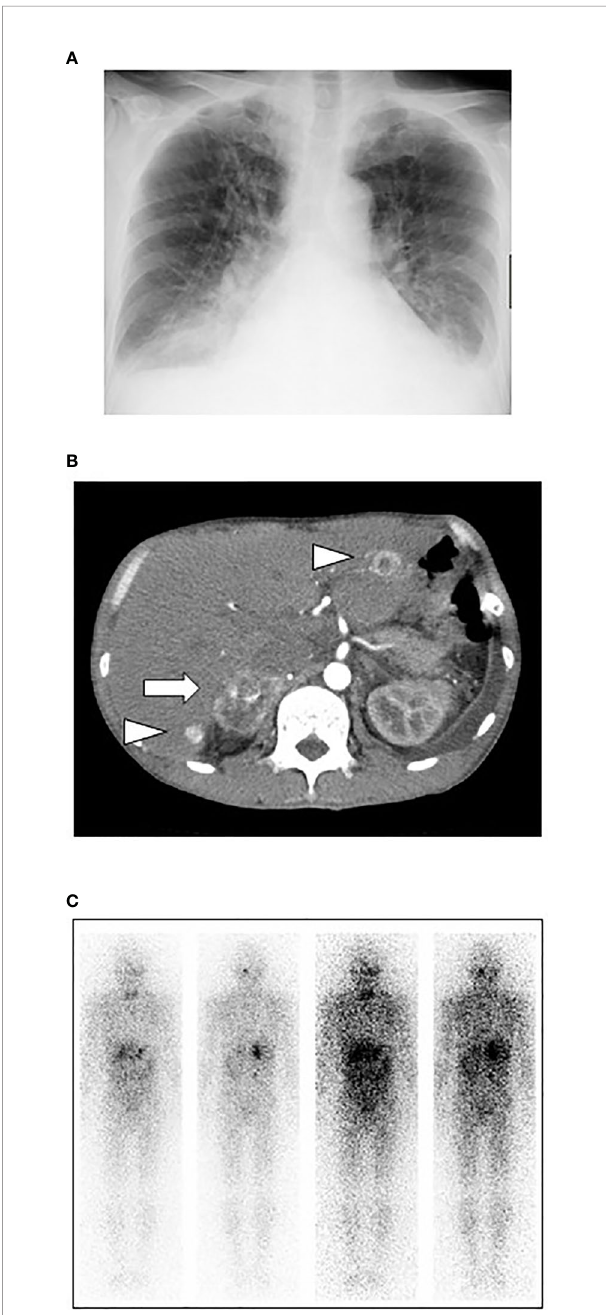
FIGURE 1 | (A) In chest X-ray, permeability was reduced in bilateral lower lung fi eld and butter fl y shadow was observed. Cardio-thoracic ratio (CTR) was 59.8% and both costophrenic angles (CPA) were blunt. (B) Abdominal contrast-enhanced computed tomography revealed a 50-mm hyper- vascularized tumor with calci fi cation in the right adrenal gland and multiple hyper-vascularized tumors in the liver. The right adrenal gland showed round shape and a mixture of high- and low-density area. In addition, since there was thin adipose tissue between the right adrenal gland and the kidney and inferior vena cava, there seemed to be no in fi ltration into surrounding organs. (C) In 131 I MIBG scintigraphy, there was high accumulation in the right adrenal gland and multiple accumulation in the liver, and there was small hot spot in the sternum and right